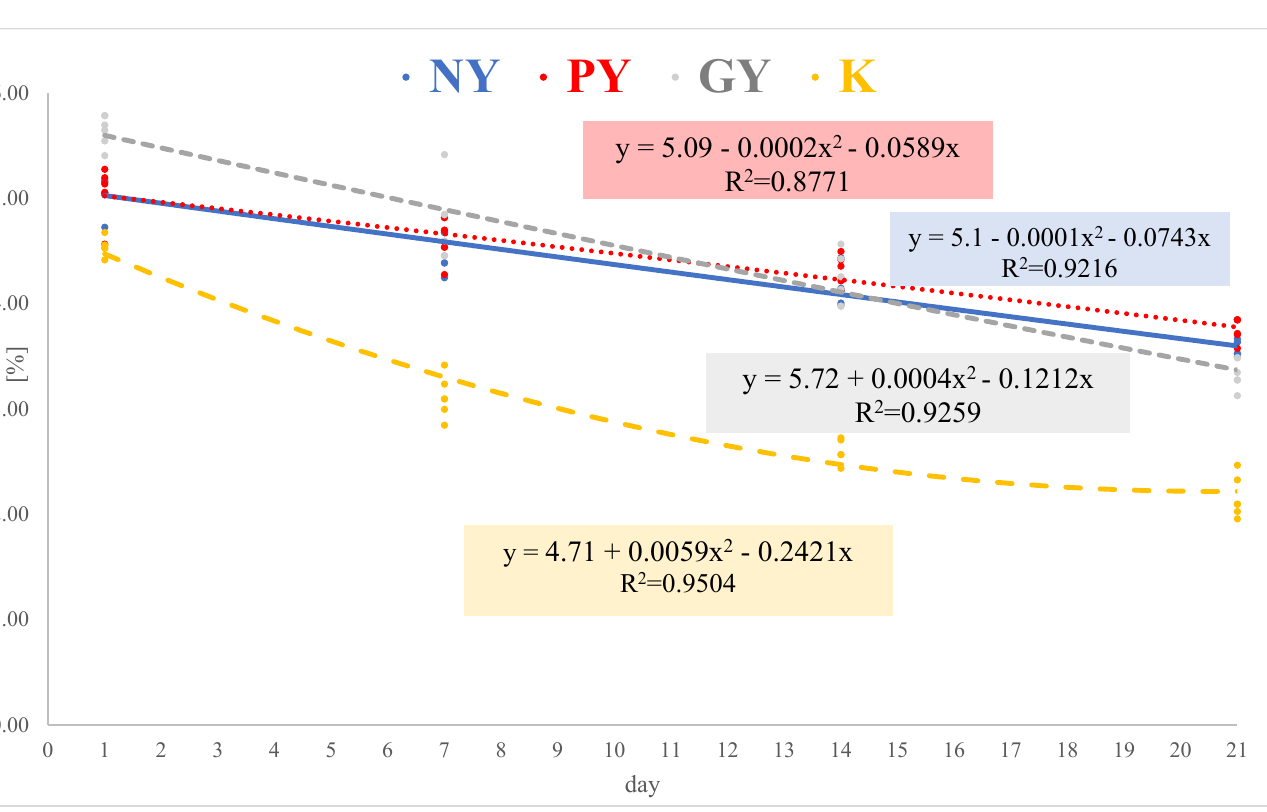
Table 2. Lactose content (%) in fermented milk drinks depends on the storage time (at 4 °C) and the type of milk drink.